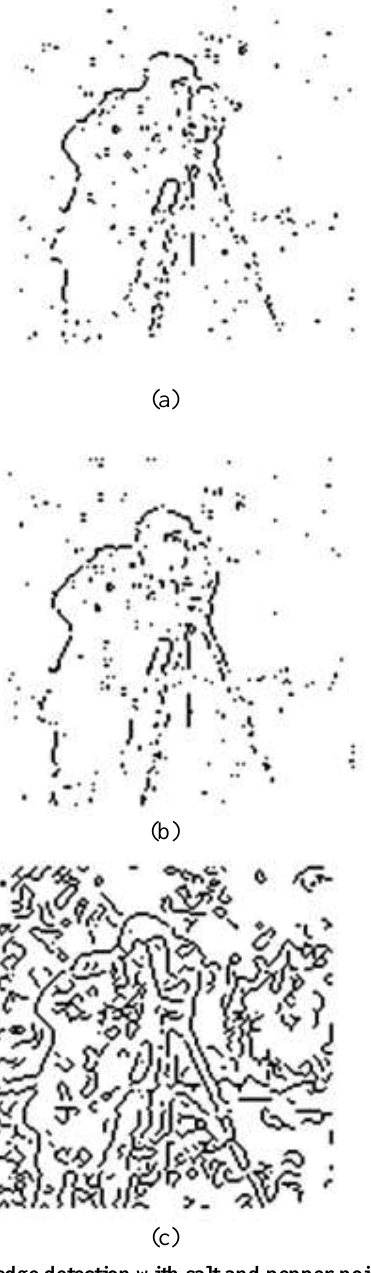
Figure 4. edge detection with salt and pepper noise and intensity= 0.1 (a) edge detection with Sobel operator, (b) edge detection with Prewitt operator, (c) edge detection with Canny operator.